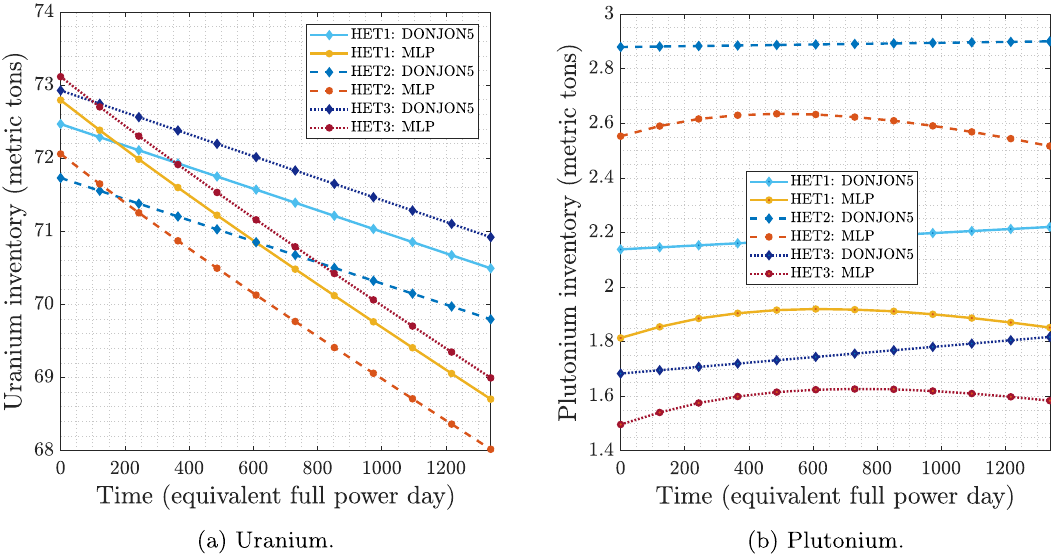
Fig. 10. Uranium (a) and plutonium (b) inventories simulated with CLASS-DONJON5 and CLASS-MLP approach for three different compositions denoted HET1, HET2 and HET3 (i.e. based on MOX1, MOX2 and MOX3, respectively). Table 12. Scenario denomination and reactors descrip- tions. Cycle lengths ( l cycle ) are in full power equivalent days and discharged burnups (BU) are in GWd · t HM